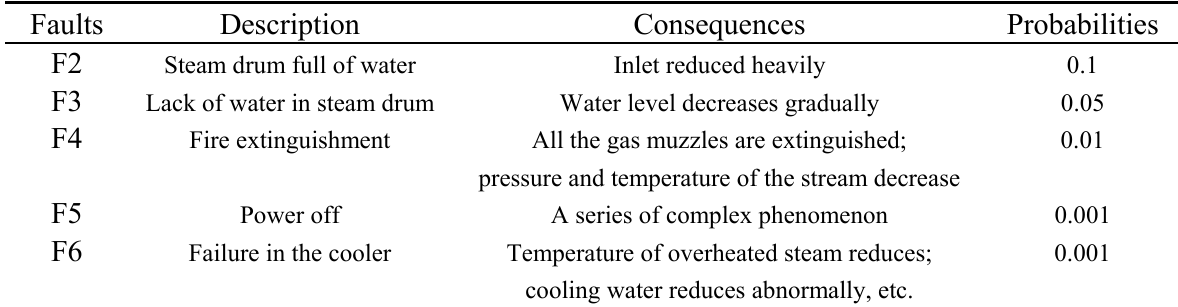
Table 1. Typical faults and their occurrence probabilities in the system.